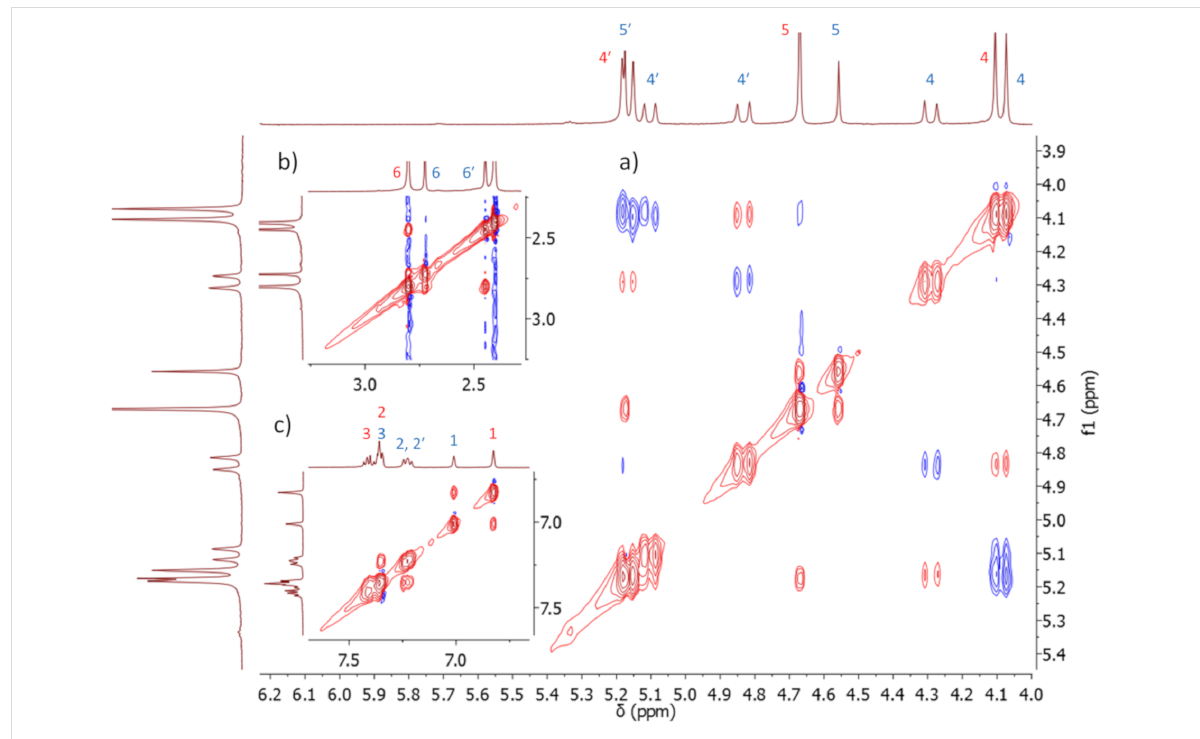
Figure 4: 2D EXSY spectra (ROESY cross-peaks in blue, EXSY cross-peaks in red) measured in MeCN- d 3 at − 40 °C. a) Zoom of the methylene and methine region, b) zoom of methyl signals, c) zoom of aromatic signals.